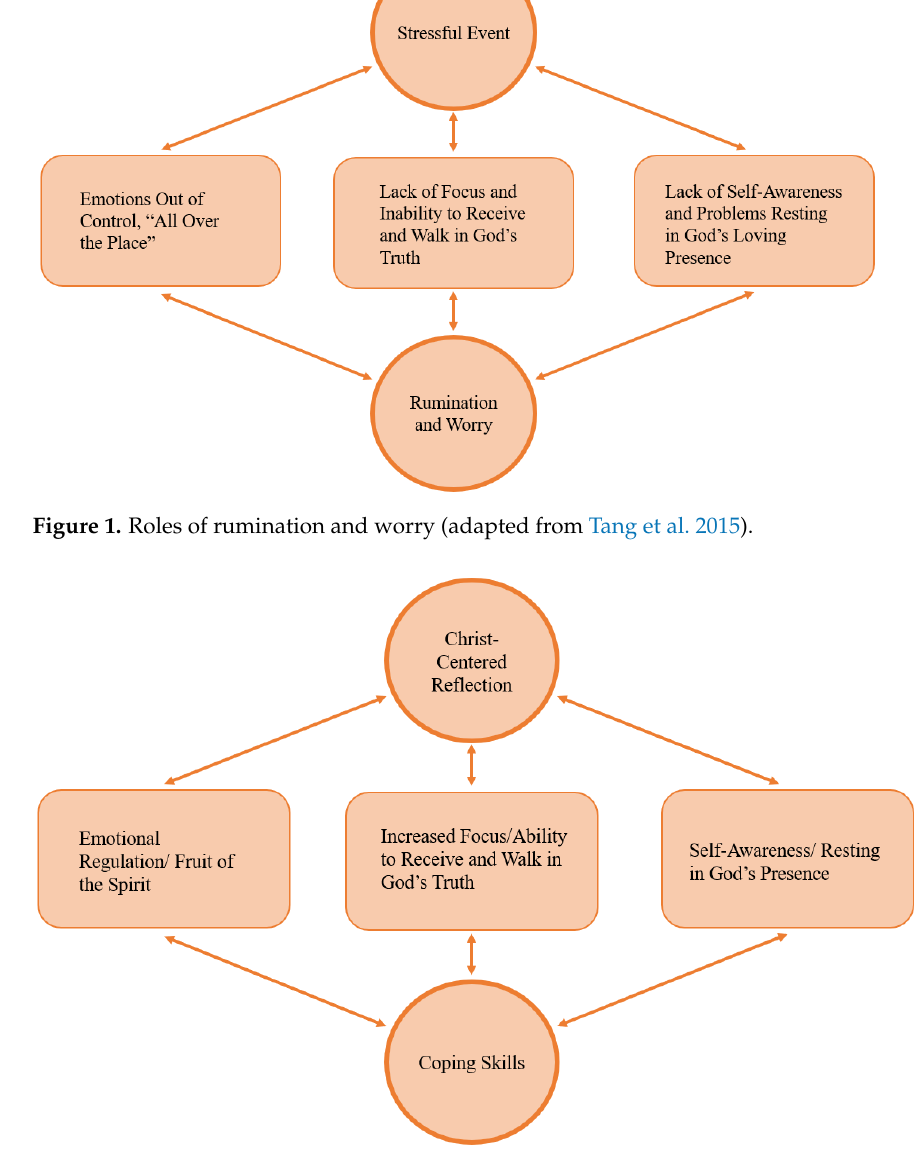
Figure 2. Benefits of Christ-centered reflection.